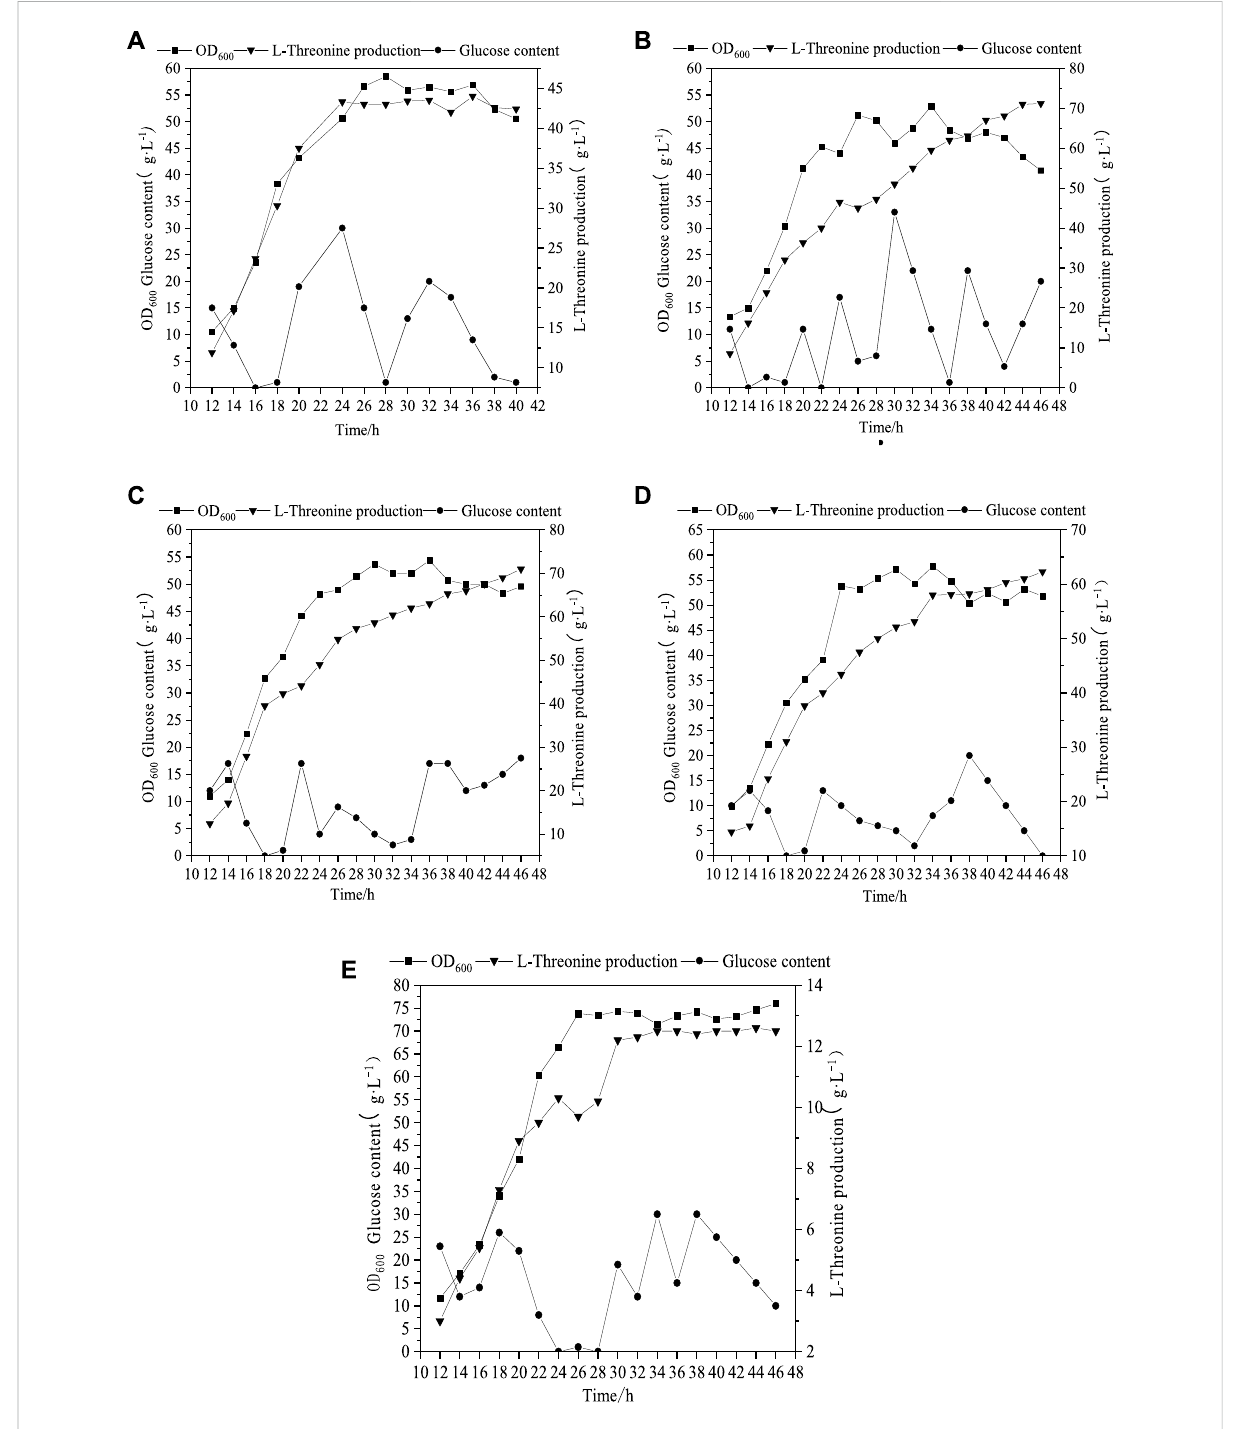
FIGURE 2 Pro fi leofThrproductionunderdifferentinitialphosphateconcentration. (A) (4.8 g L − 1 ), (B) (9.8 g L − 1 ), (C) (14.8 g L − 1 ), (D) (19.8 g L − 1 ), (E) (24.8 g L − 1 ).